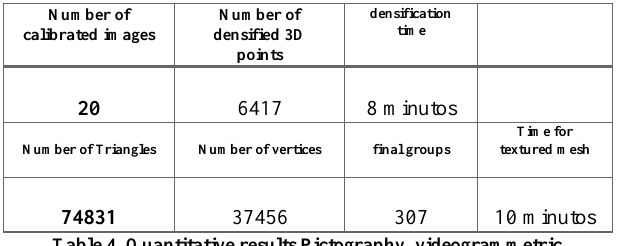
Table 4. Quantitative results Pictography, videogrammetric